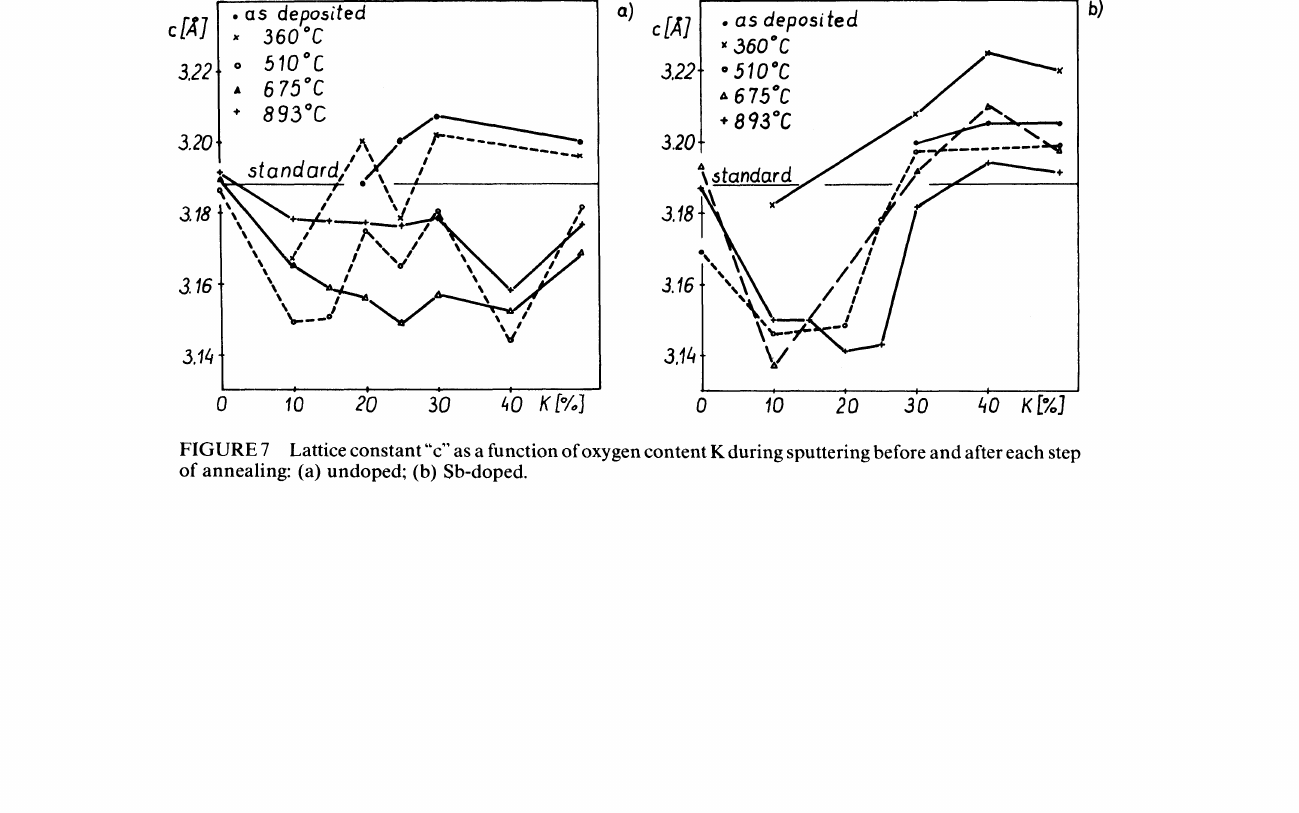
FIGURE 6 Lattice constant "a" as a function of oxygen content K during sputtering before and after each step of annealing: (a) undoped; (b) Sb-doped.